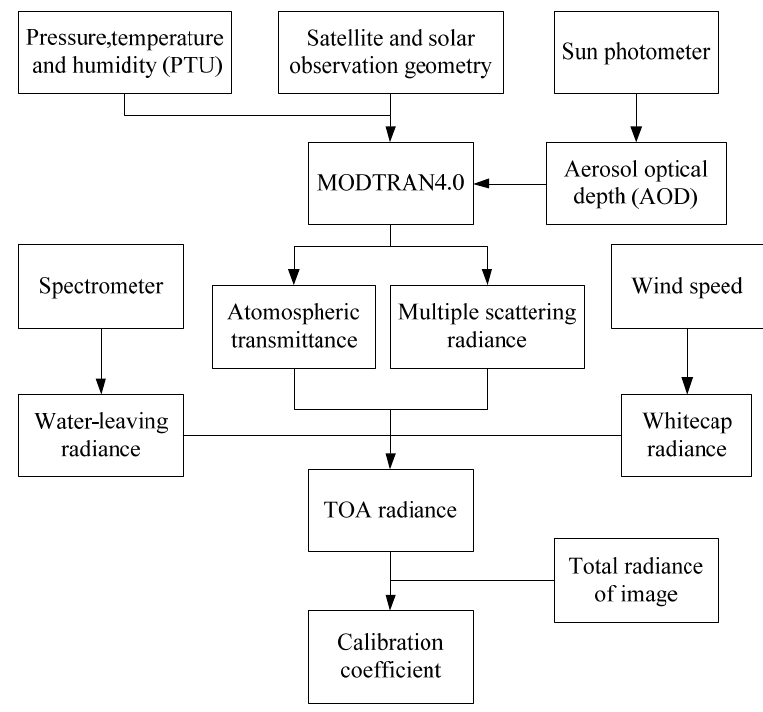
Figure 2. Flowchart of vicarious calibration method.